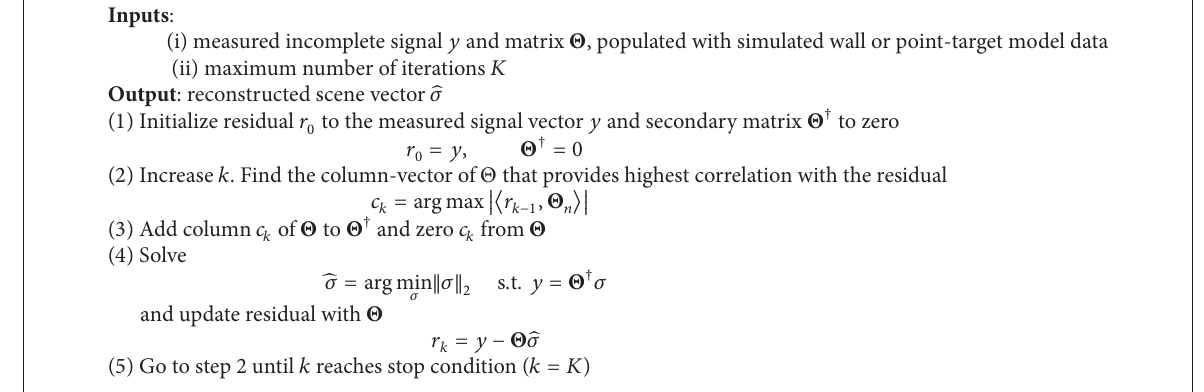
Algorithm 1: OMP algorithm description. Adapted from [26].